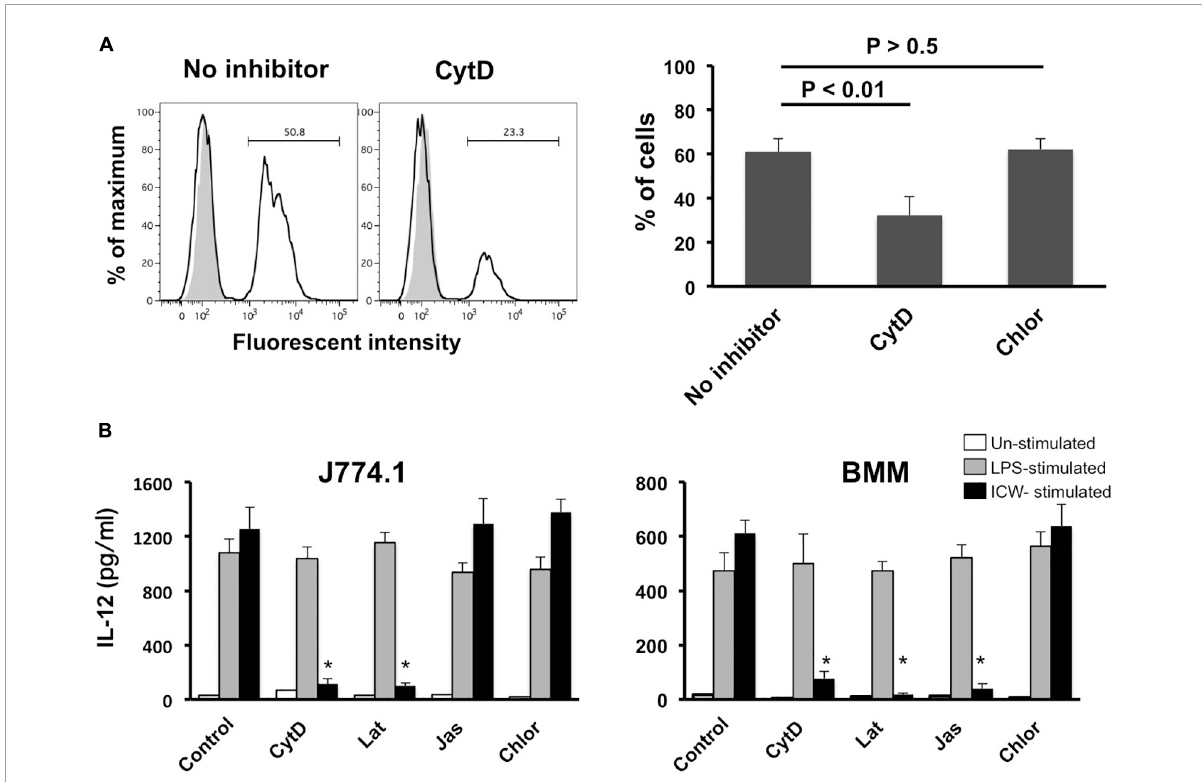
FIGURE8 Effect of actin polymerization inhibitors on uptake of ICWs and IL-12 secretion. (A) J774.1 cells were treated with cytochalasin D (CytD, 1 µ M) or chlorpromazine (Chlor, 1 µ g/ml) in complete RPMI1640 containing 0.1% DMSO for 30 min at 37 ◦ C. Fluorescein-labeled ICWs of L. plantarum TUA 5099L were added and the mixture was incubated for 30 min. Fluorescent signals in the cells were analyzed. Representative histograms (left) and percentages of positive cells among the treated cells (right) are shown. Gray and open histograms indicate untreated and fluorescein-labeled ICWs treated cells, respectively. (B) J774.1 cells and BMMs were treated with CytD (1 µ M), latrunculin B (Lat, 1 µ M), jasplakinolide (Jas, 0.1 µ M), or Chlor (1 µ g/ml) in complete RPMI1640 containing 0.1% DMSO for 30 min. Then the cells were stimulated